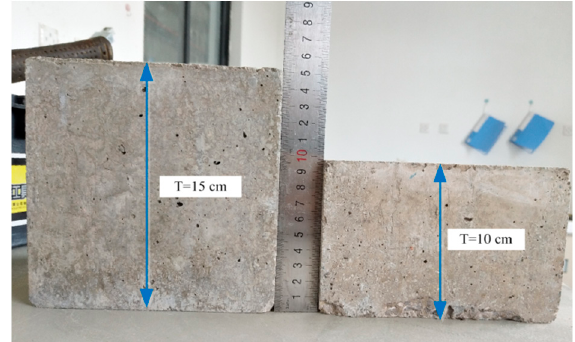
Figure 17. Standard and trimming specimens.